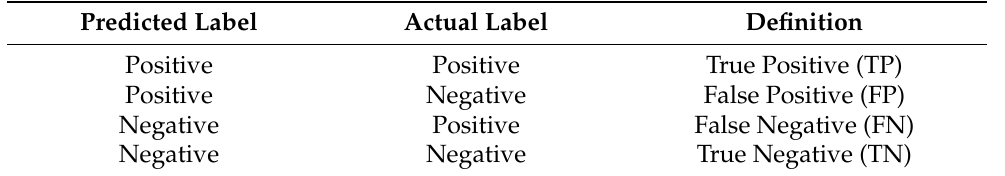
Table 2. Definition of the terms used in